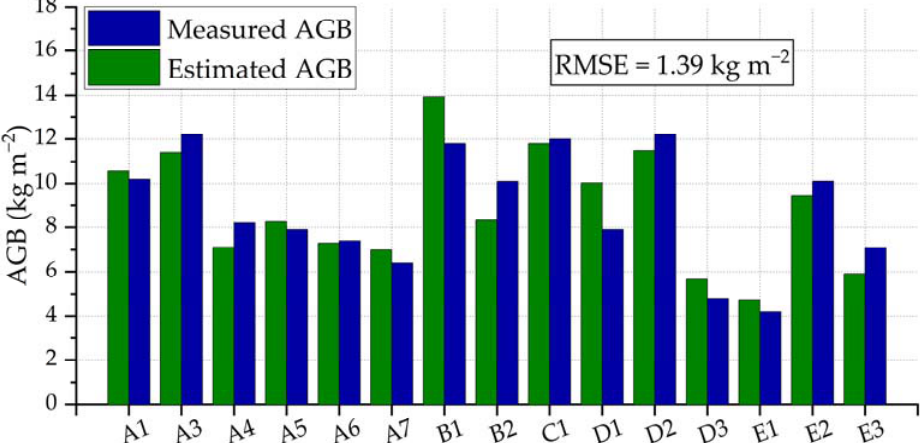
Figure 16. Comparison between the measured and estimated AGB. Data from 9 April 2020. Additional survey flights were carried out on 16 July 2020 over areas 1, 6, and 7, and measured AGB was also obtained in 17 selected sections. The estimated AGB map